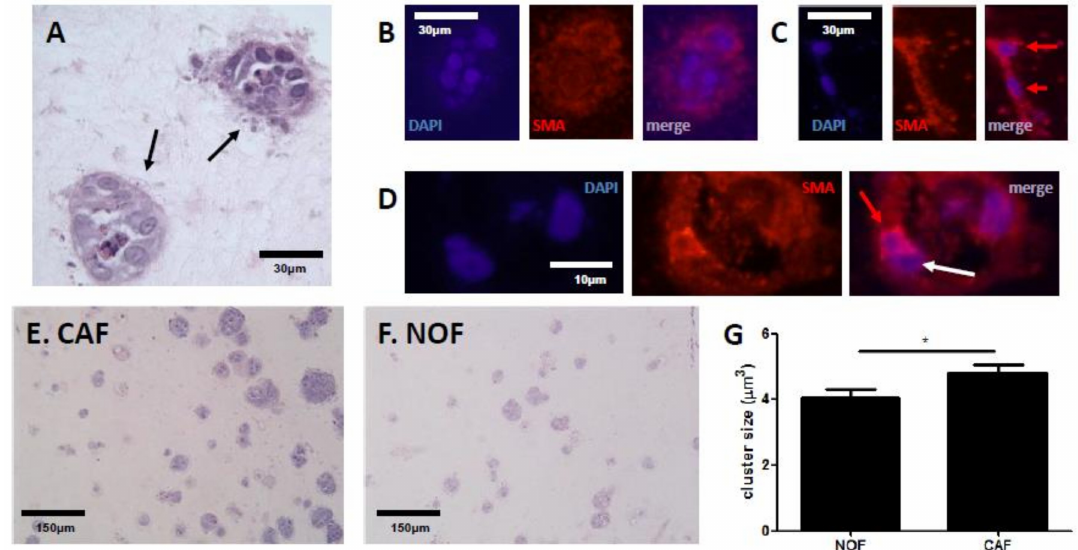
Figure 1. Colon fibroblasts mediate SW480 growth in a co-culture 3D model. Co-culture of fibroblasts with SW480 cells ( A , H&E stain), with clearly defined invasive front and stromal boundary as well as small particles that appear to be released from the clusters (black arrows). Little SMA staining was observed in the clusters ( B ), but fibroblasts were observed in the surrounding regions, with NOFs demonstrating SMA expression ( C , individual cells indicated by red arrows). By comparison CAFs showed higher expression levels of SMA ( D , SMA-positive cell indicated by red arrow), and interacted with SW480 cells (indicated by white arrow). Cluster growth was greater in co-cultures with CAFs ( E ) compared to NOFs ( F ); quantification of SW480 cluster sizes showed significantly higher sizes in co-culture with CAFs compared to NOFs ( G , n = 179 NOF, 303 CAF). * p <